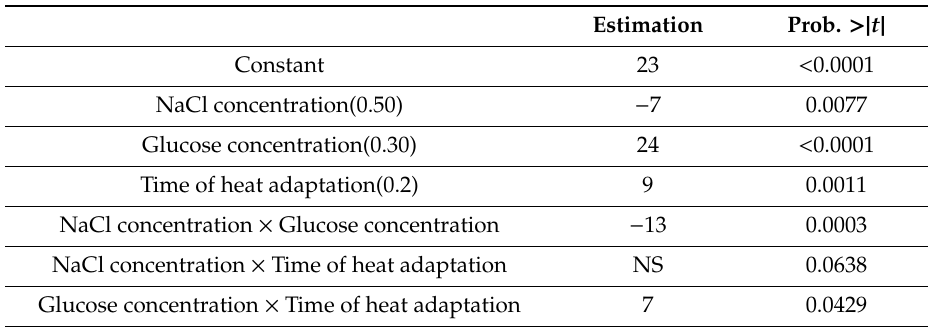
Table 2. Coe ffi cient estimation of the di ff erent variables and their interaction on P. freudenreichii viability during heat challenge. NS: not significant.